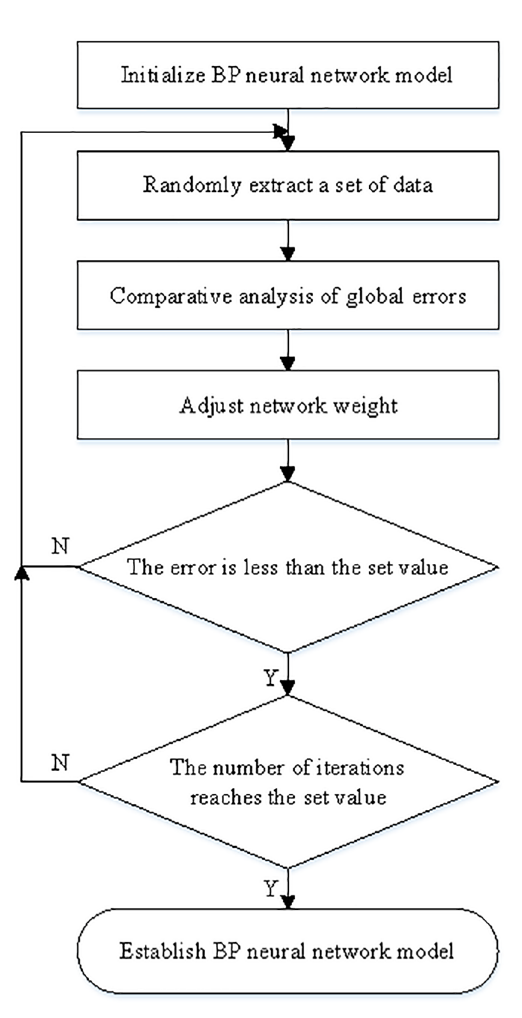
Figure 2. BP Neural Network Algorithm Learning